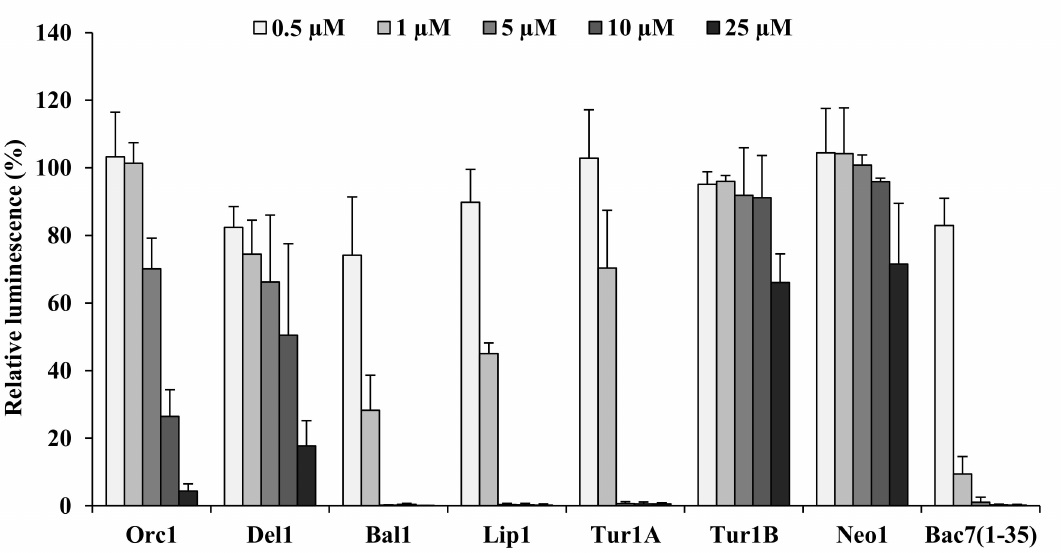
Figure 3. Luciferase activity after in vitro transcription / translation reactions in presence of cePrAMPs. E. coli extracts were incubated with the firefly luciferase reporter DNA in the presence of increasing concentrations of cePrAMPs. Results are presented as the percentage with respect to control samples treated with only RNase-free water. Average and standard deviation of at least three independent experiments ( n ≥